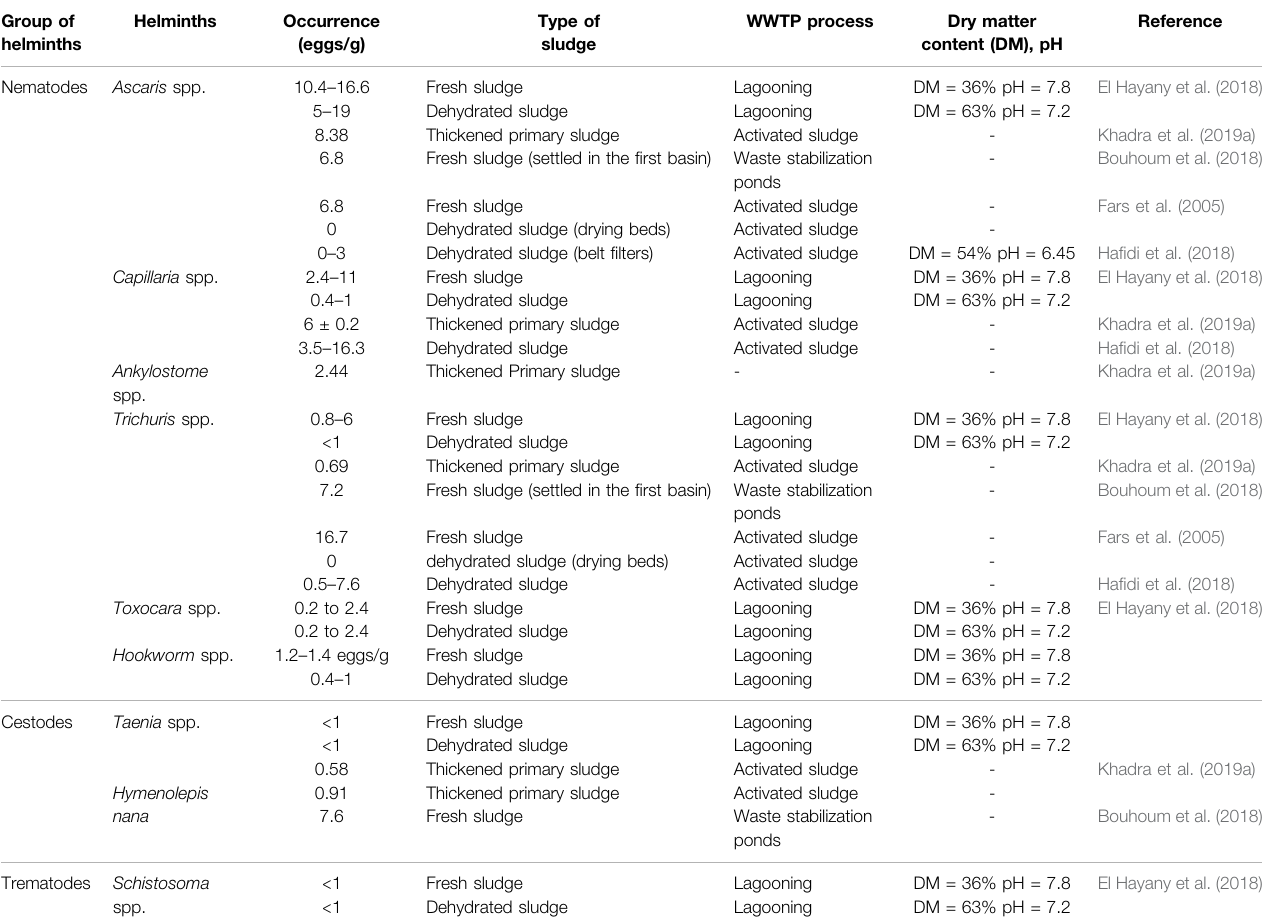
TABLE 7 | Helminth eggs occurrence in SS in Morocco. Group of Helminths helminths Ascaris spp.